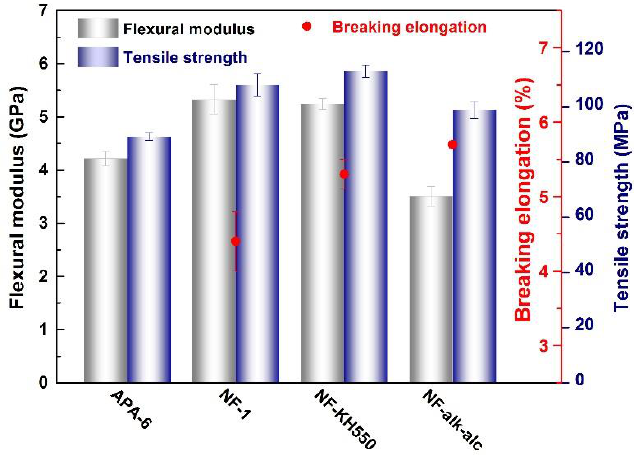
Figure 11. The mechanical properties of different modified ramie fabrics reinforced APA-6 composites.